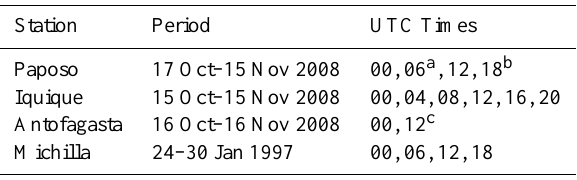
Table 2. Times of coastal upper air observations during VOCALS- REx and Michilla,